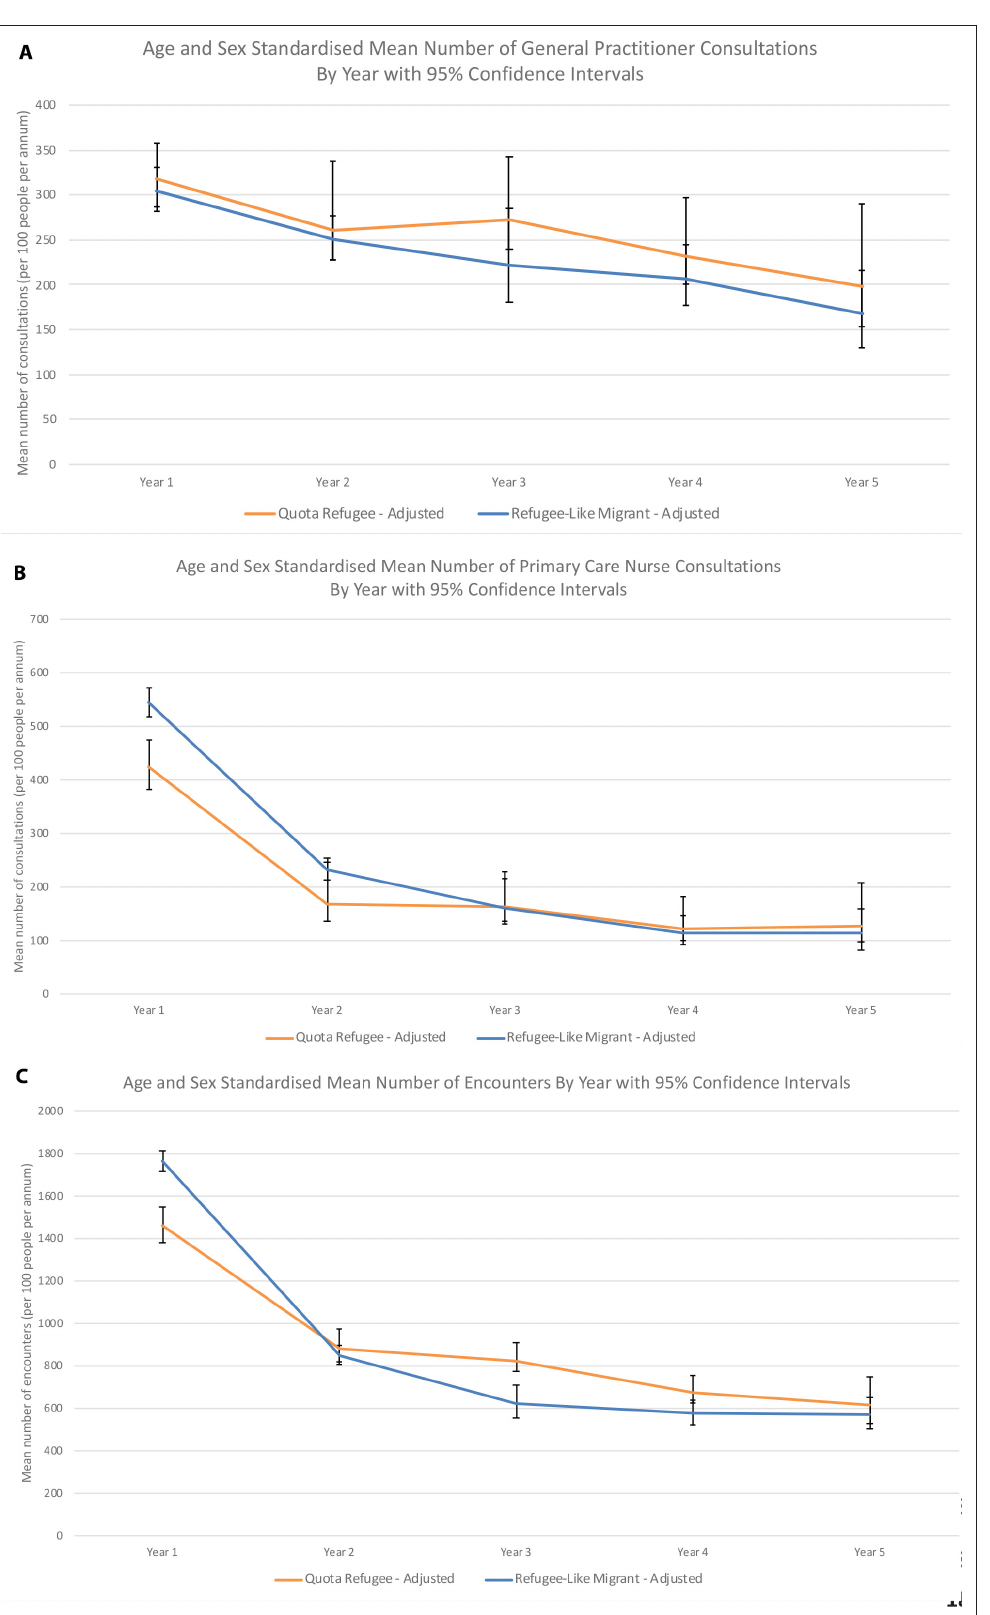
Figure 2 Age and sex standardised: a) GP consultations, b) primary care nurse consultations, and c) ‘encounters’, by year after arrival with 95% confidence